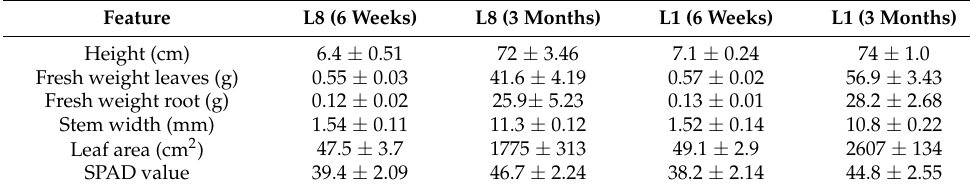
Figure 1. Phenotype of transgenic tobacco plants. In the photos, there is shown the phenotype characteristics of the transgenic plants in two physiological ages. The first, at 6-weeks-old both plants ( A ) L1 and ( B ) L8 were practically identical. At this age, samples were taken for the WGBS. At 3-months-old, both plants still looked similar, but the plants ( C ) L1 presented a light yellowing in the basal leaves compared with the ( D ) L8 plant. Table 1. Physiological